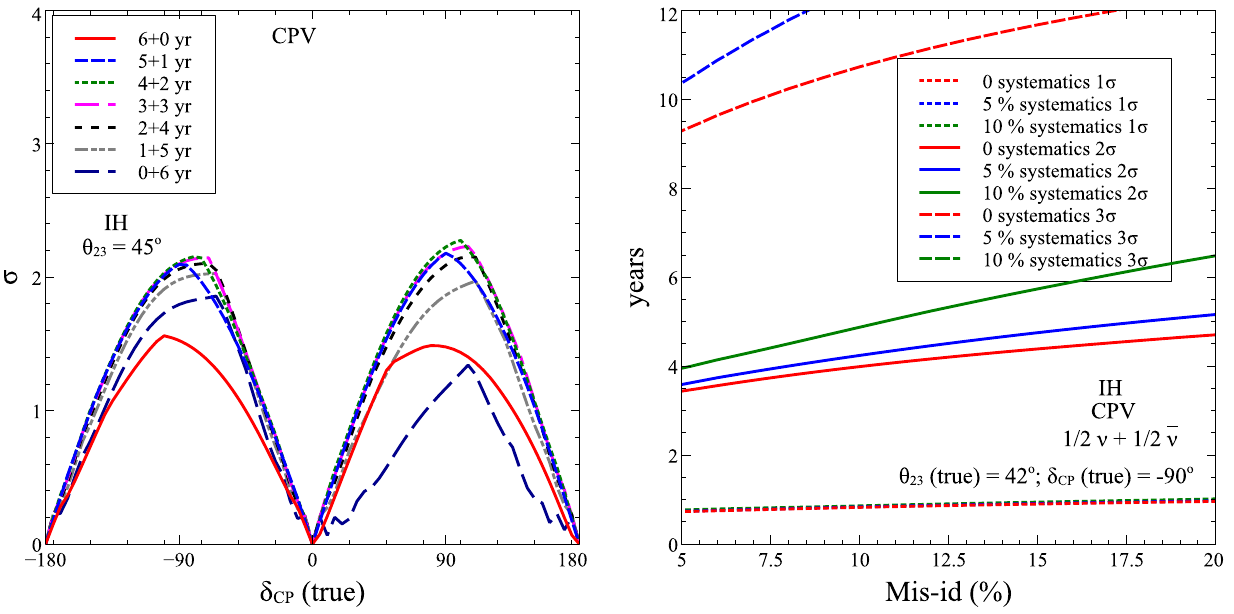
Fig. 11 The left panel shows the CPV sensitivity as a function of δ CP (true) in IH for θ 23 = 45 ◦ . The right panel shows the impact of systematics and backgrounds on the CPV sensitivity in IH in terms of runtime required to achieve a sensitivity of a certain confidence level. This is for θ 23 = 45 ◦ and δ CP = − 90